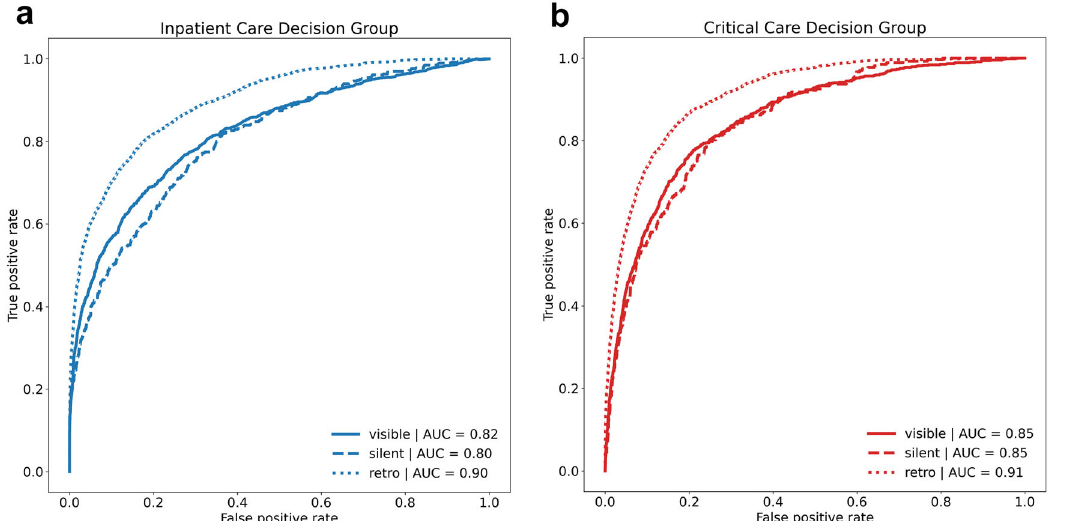
Fig. 2 Model performance assessment. Receiver operating characteristic (ROC) curves are shown for our ( a ) inpatient care and ( b ) critical care outcome prediction models. ROC curves and measurements of area under the curve (AUC) are shown for three separate validation cohorts: retrospective out-of-sample (retro), prospective but prior to decision support activation (silent) and prospective after decision support activation (visible). Performance assessment was limited to patients not meeting outcome criteria prior to ED disposition decision.